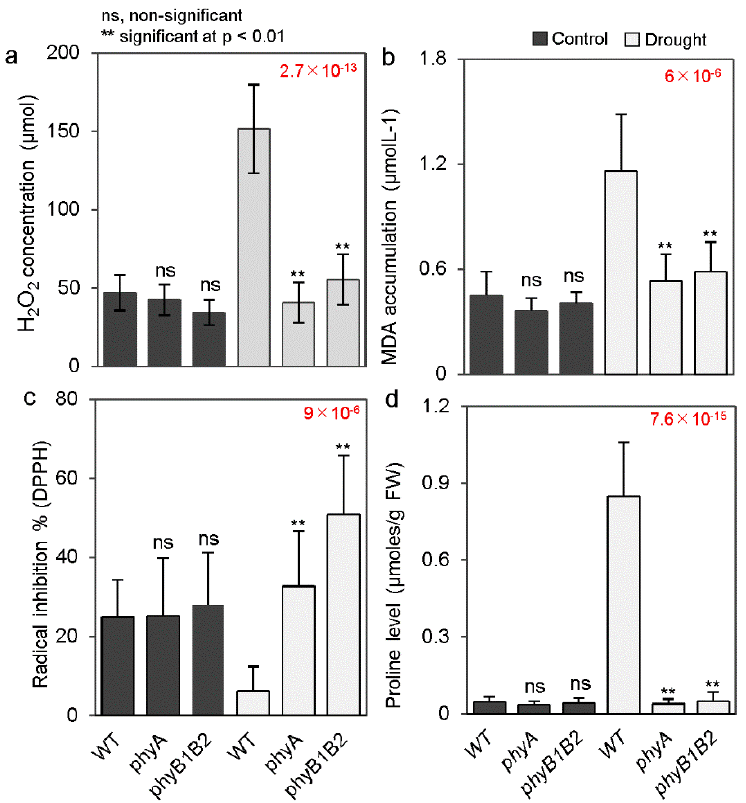
Figure 2. Oxidative damage and proline level of WT, phyA , and phyB1B2 plants under drought stress. Hydrogen peroxide (H 2 O 2 ) concentration ( a ), malondialdehyde (MDA) accumulation ( b ) , free radical inhibition % via 2,2-diphenyl-1-picrylhydrazyl (DPPH) ( c ), and proline level ( d ) of one-month-old plants under control and water-withholding conditions. H 2 O 2 data represent the average of six plants ± SD (standard deviation), whereas the other data represent the average ( n ≥ 4) ± SD from a representative of three biological individualistic experiments. Double asterisks signify the statistically significant variants ( p < 0.01), whereas ns represents the statistically non-marked differences between studied genotypes under non-stress and stress conditions following a post hoc Tukey HSD test with ANOVA. ANOVA p-values are presented in red. Additionally, the p -values of the post hoc test are presented in Supplementary Materials (Table S2).